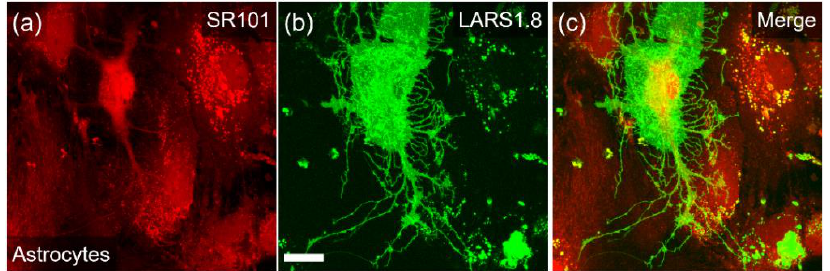
Figure 2. Cellular expression in primary mouse astrocytes. Confocal images of live mouse astrocytes transfected with LARS1.8 and observed 48 h after transfection. ( a ) SR101 dye staining (λ ex = 561 nm), ( b ) endogenous cpGFP fluorescence (λ ex = 488 nm), and ( c ) merged image. Note the cpGFP green staining extending to the finest membrane processes. Scale bar, 20 µm.